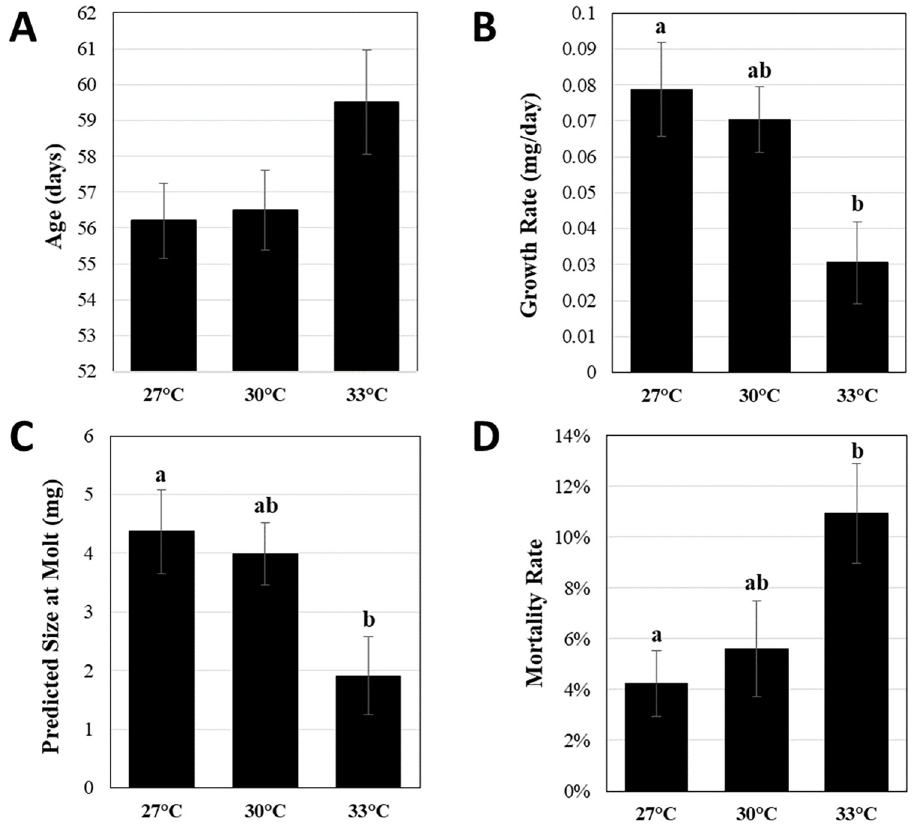
Fig 5. Effects of elevated temperatures on development. (A) Average molt times for spiderlings reared at different temperatures. (B) Average growth rates were measured from 55–75 days of development for spiderlings reared at different temperatures. (N = 6 families per treatment) (C) Average spiderling size at time of second molt was predicted from molt times and growth rates for each family (N = 6 families per treatment). (D) Spiderling mortality at each temperature was determined from 55–75 days of development for each family. (A-D) Different lowercase letters indicate significant differences (p < 0.05). N = 6 families per treatment.